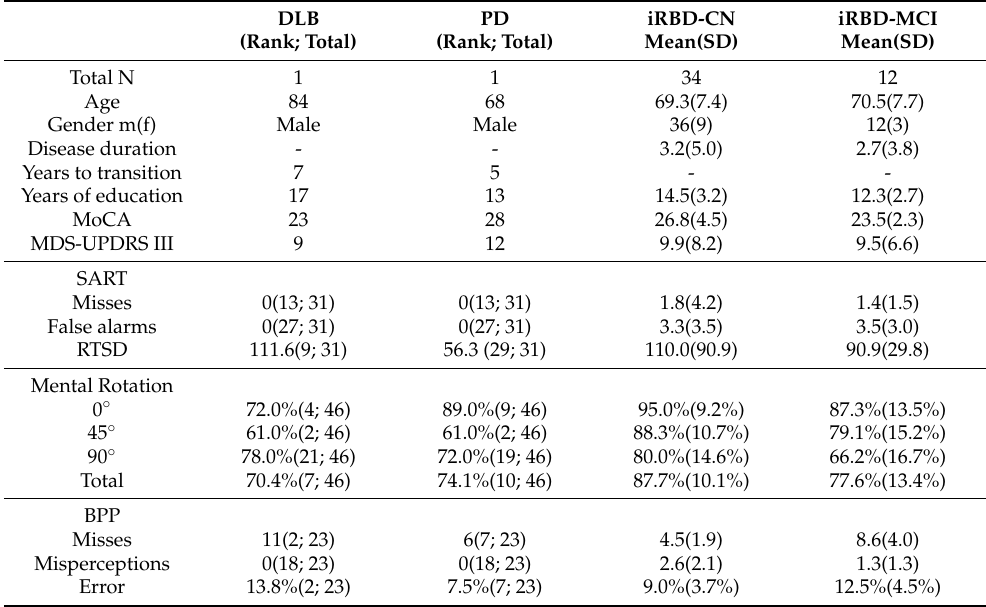
Table 2. Baseline demographic and task performance between transition and stable iRBD patients. Rank of 1 indicates the most impaired of the